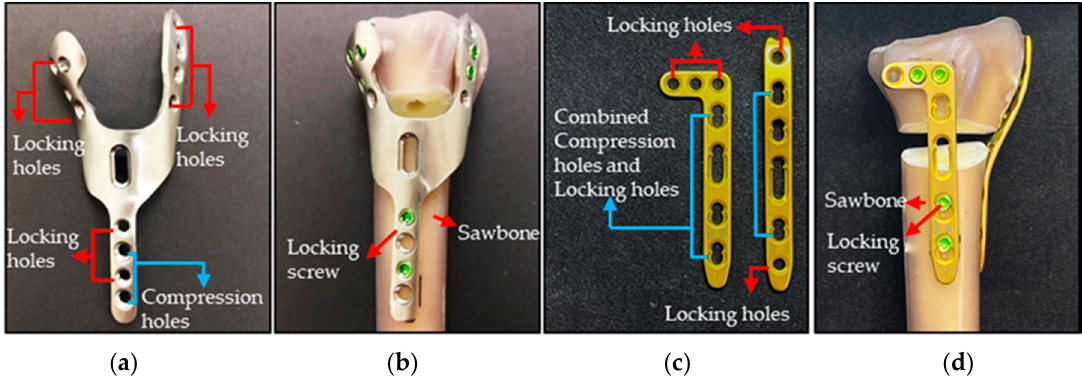
Figure 1. ( a ) Profile of the novel HDDP presented a “Y” shape with 1.6 mm thickness, fabricated using Ti6Al4V alloy. ( b ) The HDDP was fixed onto one of the radius Sawbones using self-tapping 2.4 mm locking screws bicortically in the shaft and unicortically in the distal end. ( c ) The dorsal double-plating (DDP) consists of one “L” shape plate and one straight plate with 1.6 mm thickness, fabricated using Ti6CP alloy. ( d ) The DDP was fixed onto one of the radius Sawbones using self-tapping 2.4 mm locking screws bicortically in the shaft and unicortically in the distal end around the fixation screws.